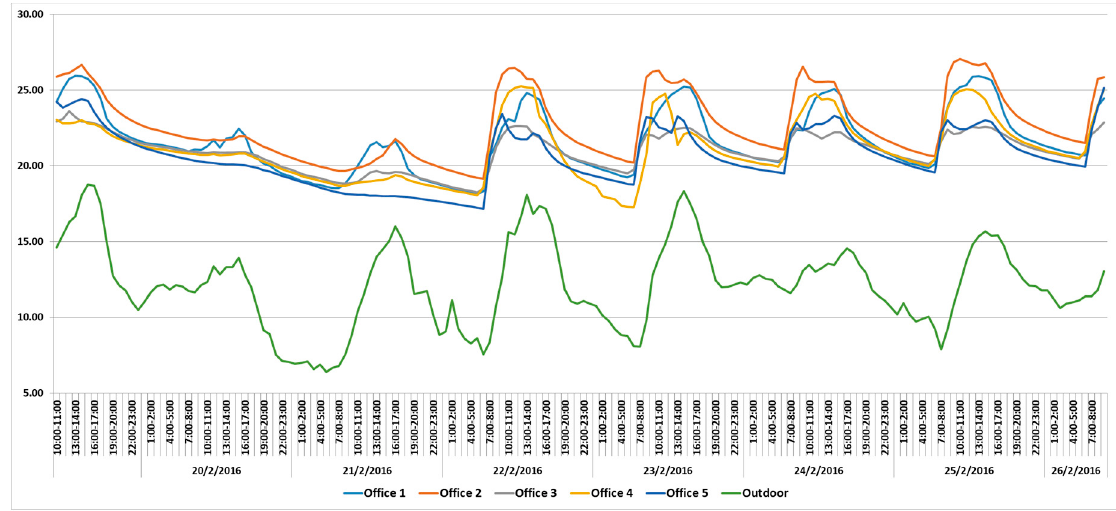
Figure 2. Temperature levels of the external and all the indoor environment of Building A during winter.